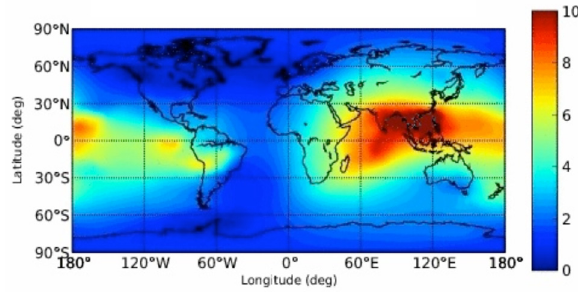
Figure 2. GIM at 05:47 UTC on March 11, 2011.